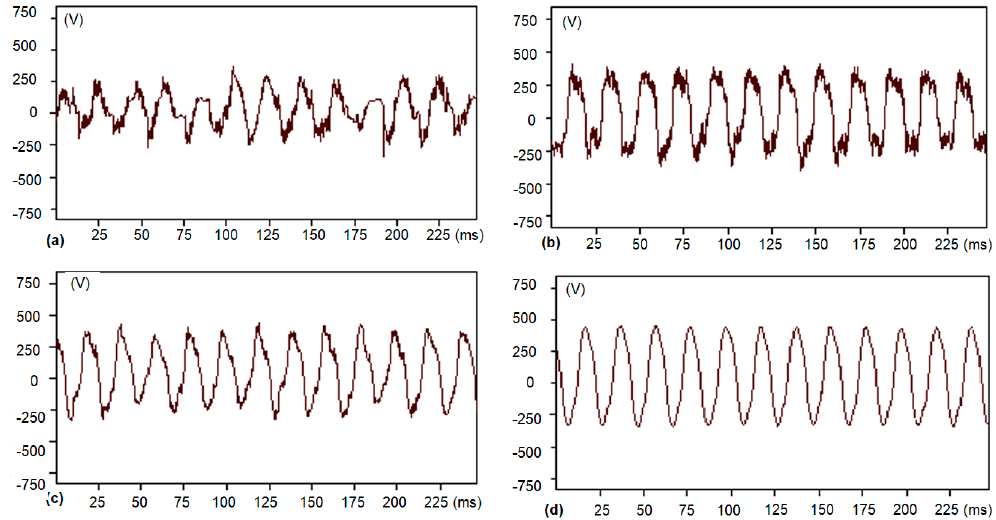
Figure 17. Waveforms of arc voltage in individual stages of smelting: ( a ) arc ignition; ( b ) start of melting the charge; ( c ) main melting phase; ( d ) final stage of smelting [58]. Energies 2020 , 13 , x FOR PEER REVIEW